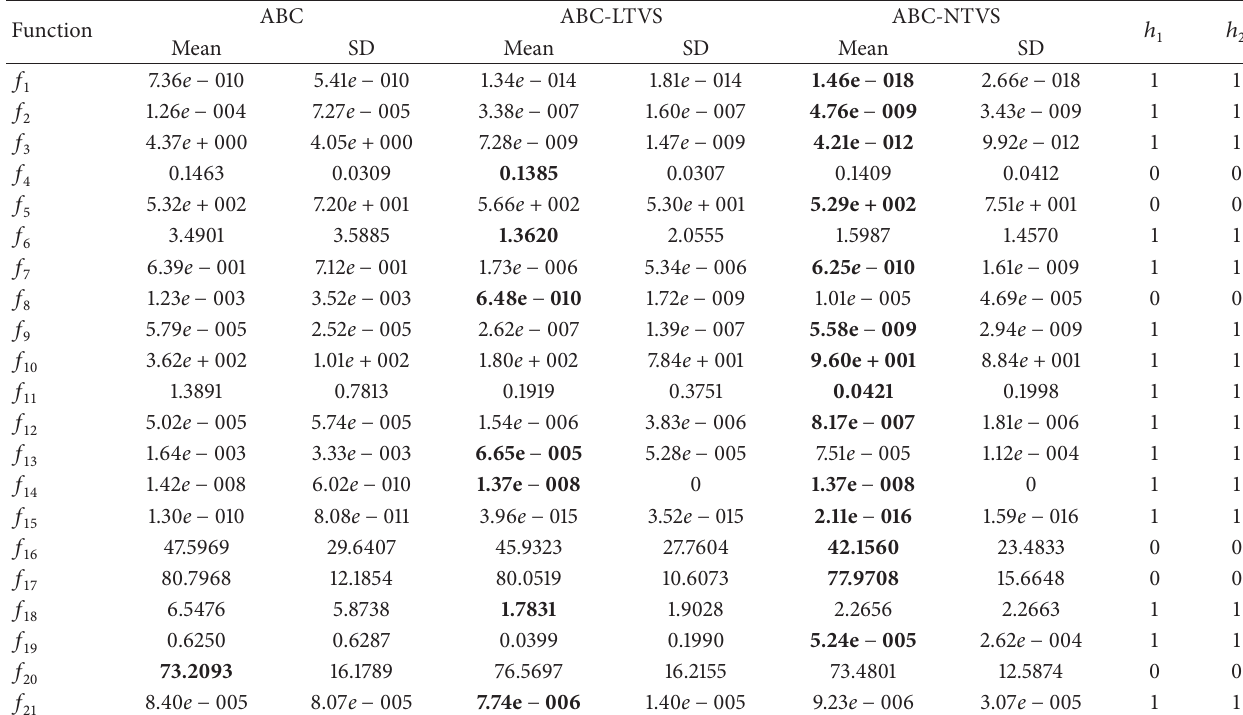
Table 5: Experimental results for 30-dimension